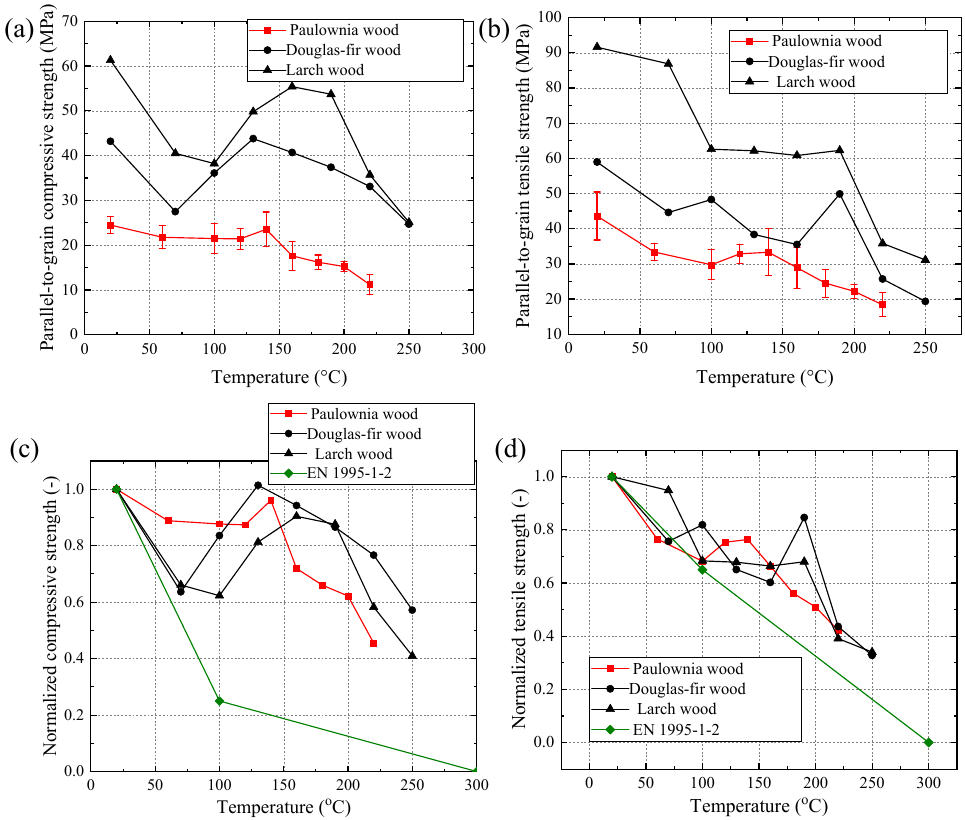
Figure 11. Strength degradation of the wood samples [10,20,21]: ( a ) compression; ( b ) tension; ( c ) normalized compressive strength; and ( d ) normalized tensile strength. Table 3. Temperature-dependent average strengths and the corresponding deformations.